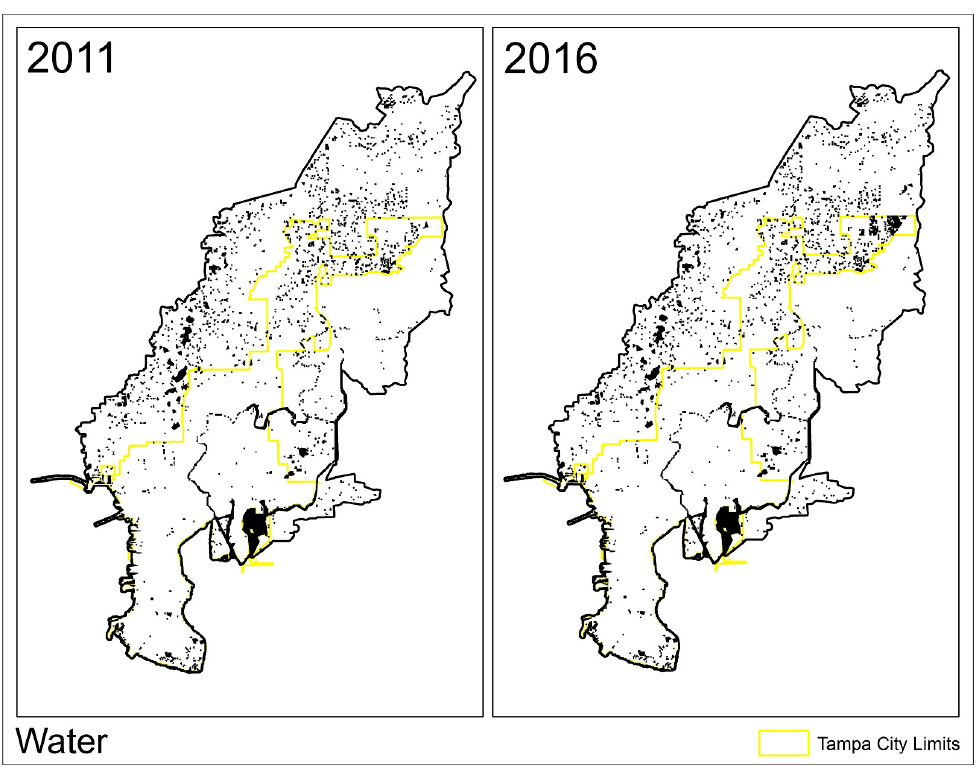
Figure A11. Observed (2011) and Modeled (2016) LULC distribution for the “Water” class.